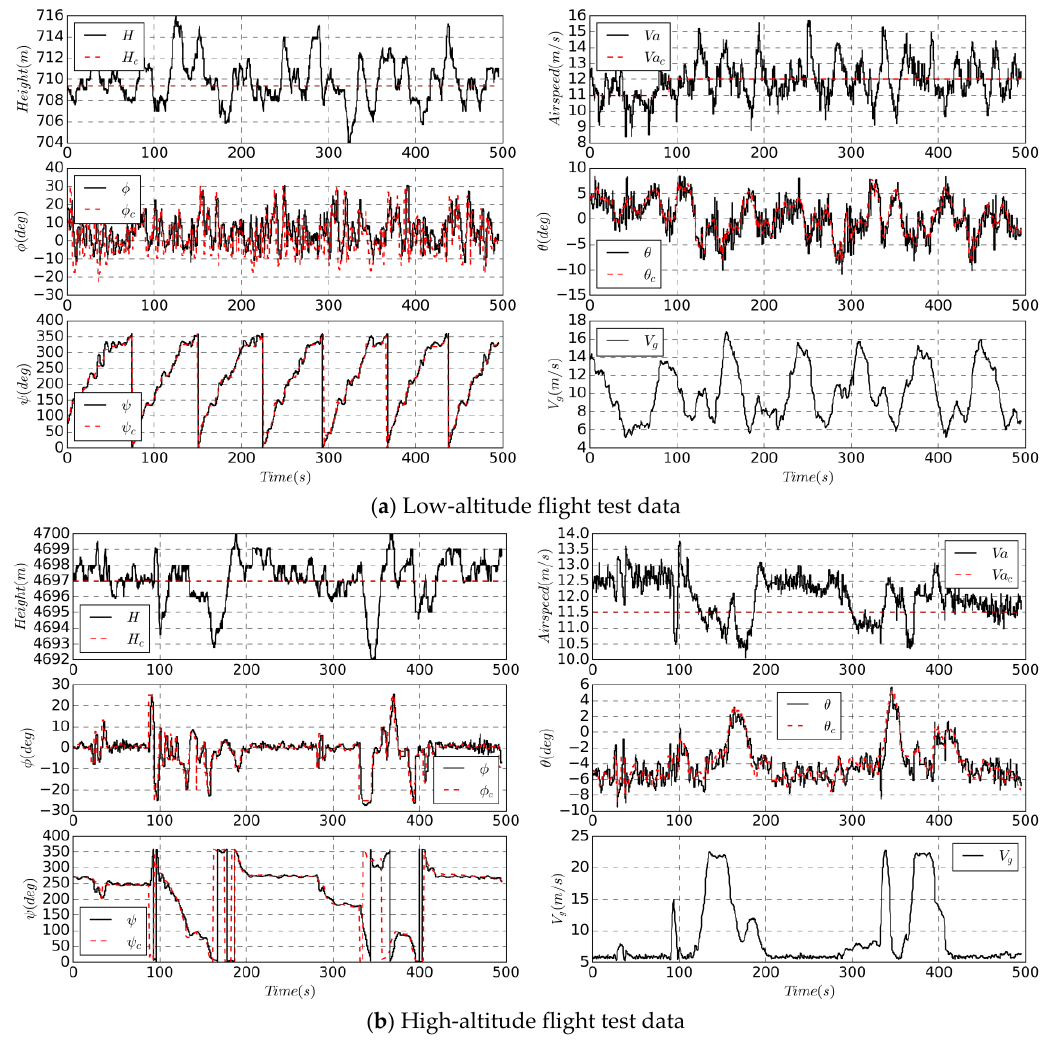
Figure 21. Flight data in the cruise phase of low and high altitude. Table 10. Flight parameters for four typical phases at di ff erent